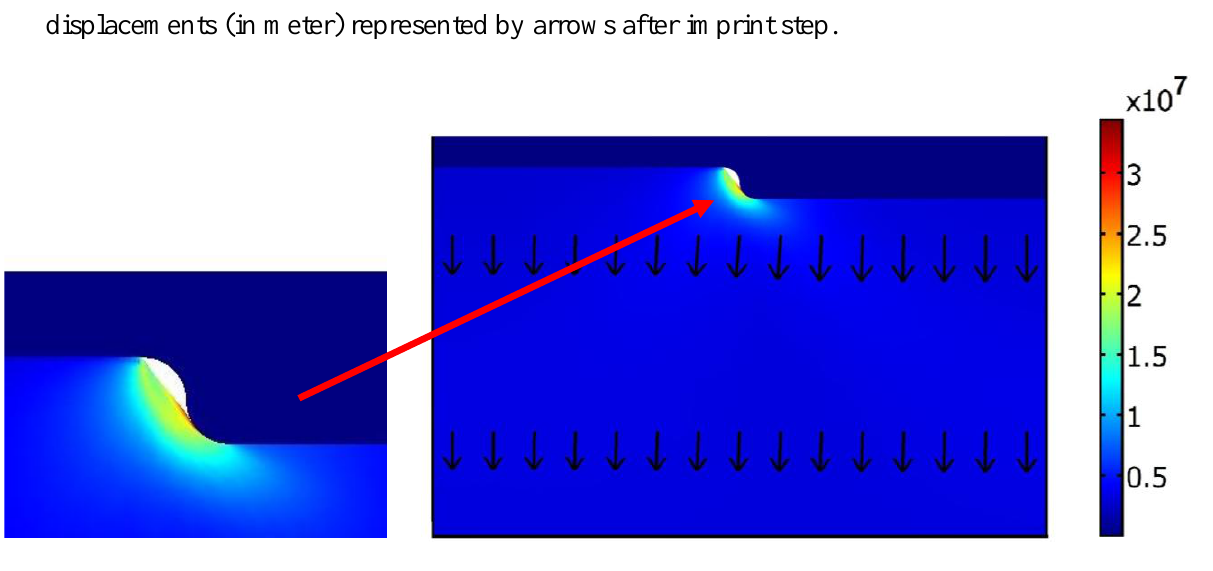
Figure 10. Areas of the permissible yield and profile of the experimental microrelief represented by the red